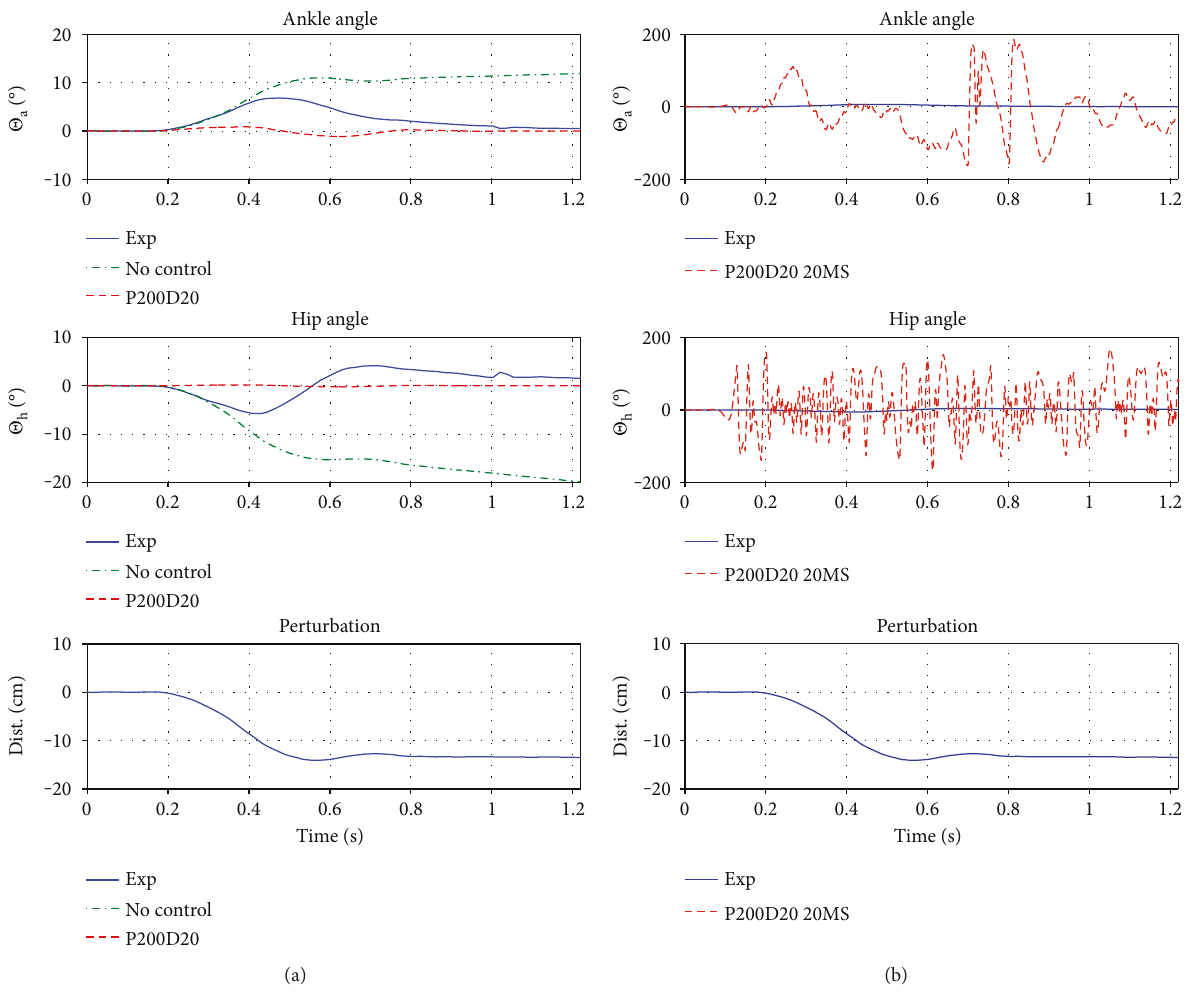
Figure 6: (a) Experiment trajectory in blue, “ no control ” (I) in red, and PD control (IIa) in dashed red. (b) Experiment trajectory in blue and PD control with 20 ms delay (IIb) in dashed red. First plot is the ankle trajectory, second is the hip, and third is the perturbation. While with no control applied, the system obviously collapses, also simple PD control, while being able to stabilize was not able to match the angular trajectories of the experiment. If a delay is introduced, the system becomes highly unstable. The PD controller used here is the MATLAB:Simulink build in PID controller with P = 200 , D = 20 , I = 0 , and N = 100